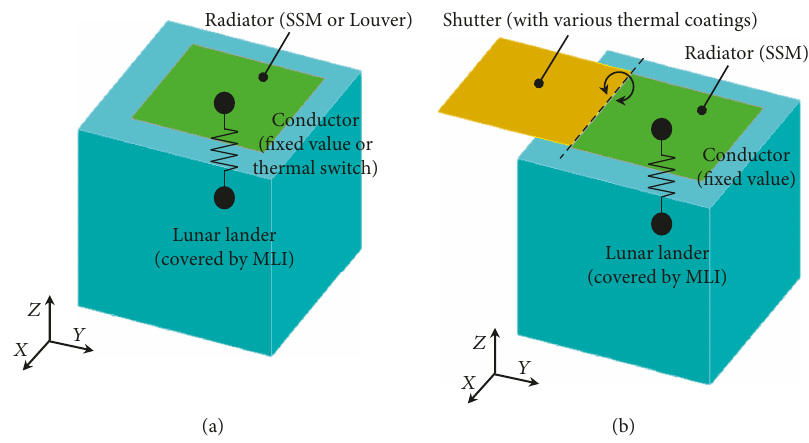
Figure 4: TMM of the lunar lander ((a) without shutter (b) with